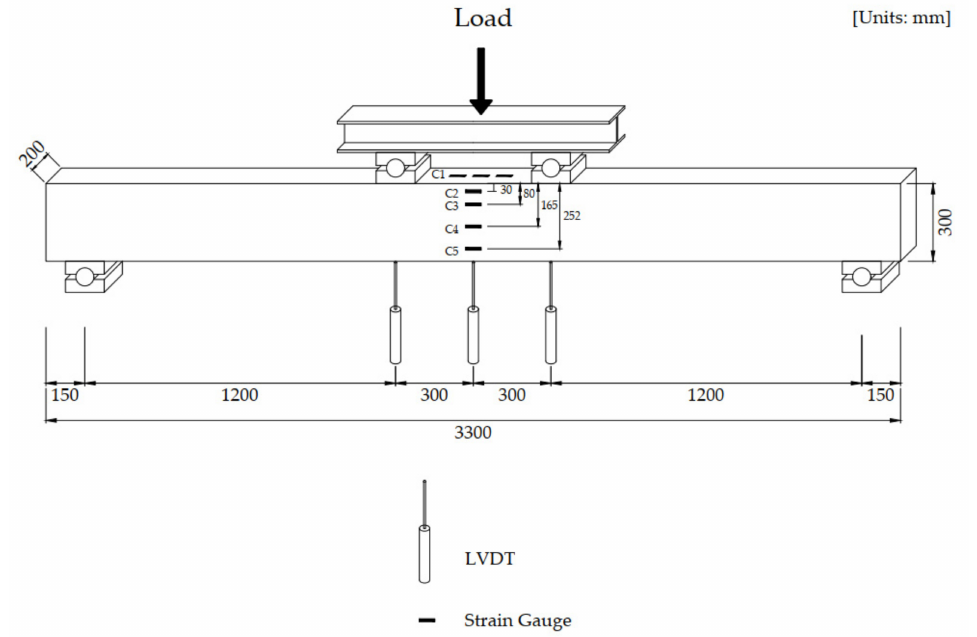
Figure 5. Instrumentation used for the flexural tests of the